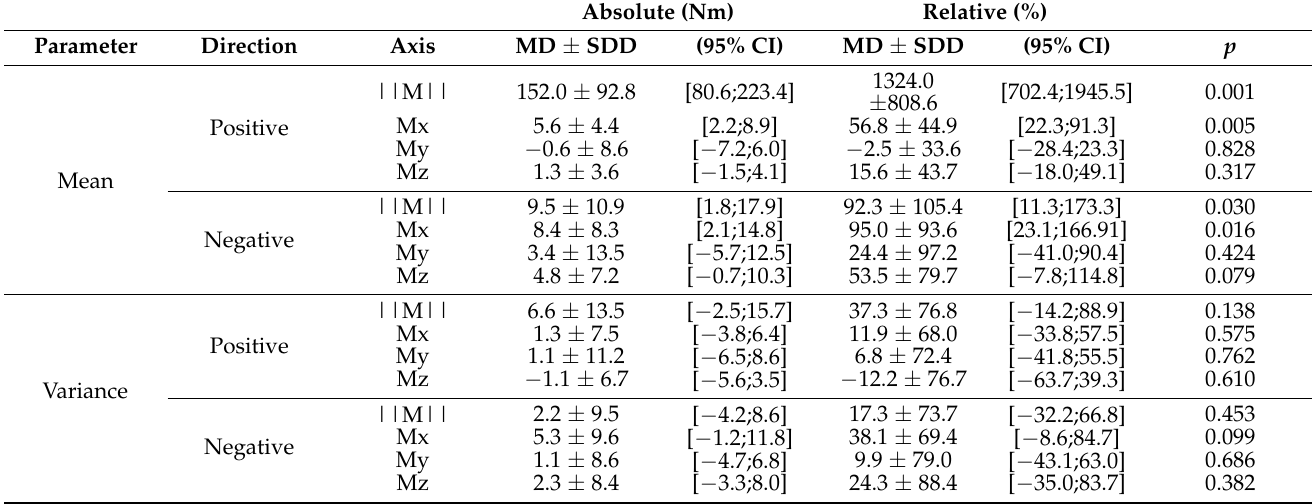
Table 8. Direction of the net moment of the magnitude and around the axis of the light vs. heavy tasks. Shown are the absolute (Nm) and relative (%) differences between the light tasks and the heavy tasks through mean (MD: heavy–light task), standard deviation (SDD), and 95% confidence interval (CI) of these differences for the anterior–posterior (Mx) with lateroflexion to the left (positive) and right (negative), mediolateral (My) with flexion (positive) and extension (negative), longitudinal (Mz) with rotation to the left (positive) and right (negative) axes separately and for the moment magnitude (||M||) with a p -value of paired t -test. Absolute (Nm) Relative